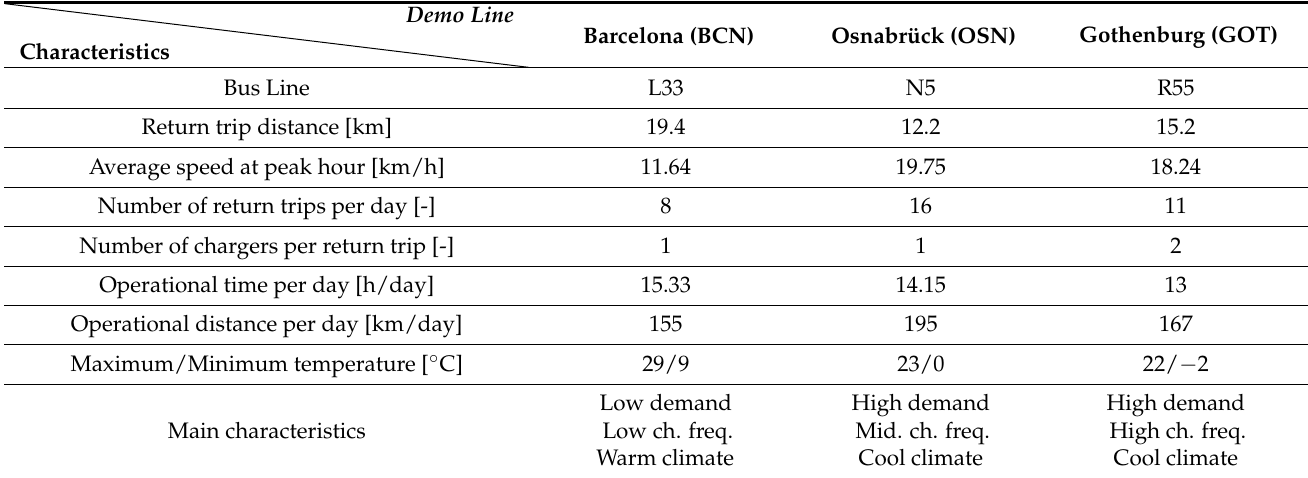
Table 8. Demo route lines and their